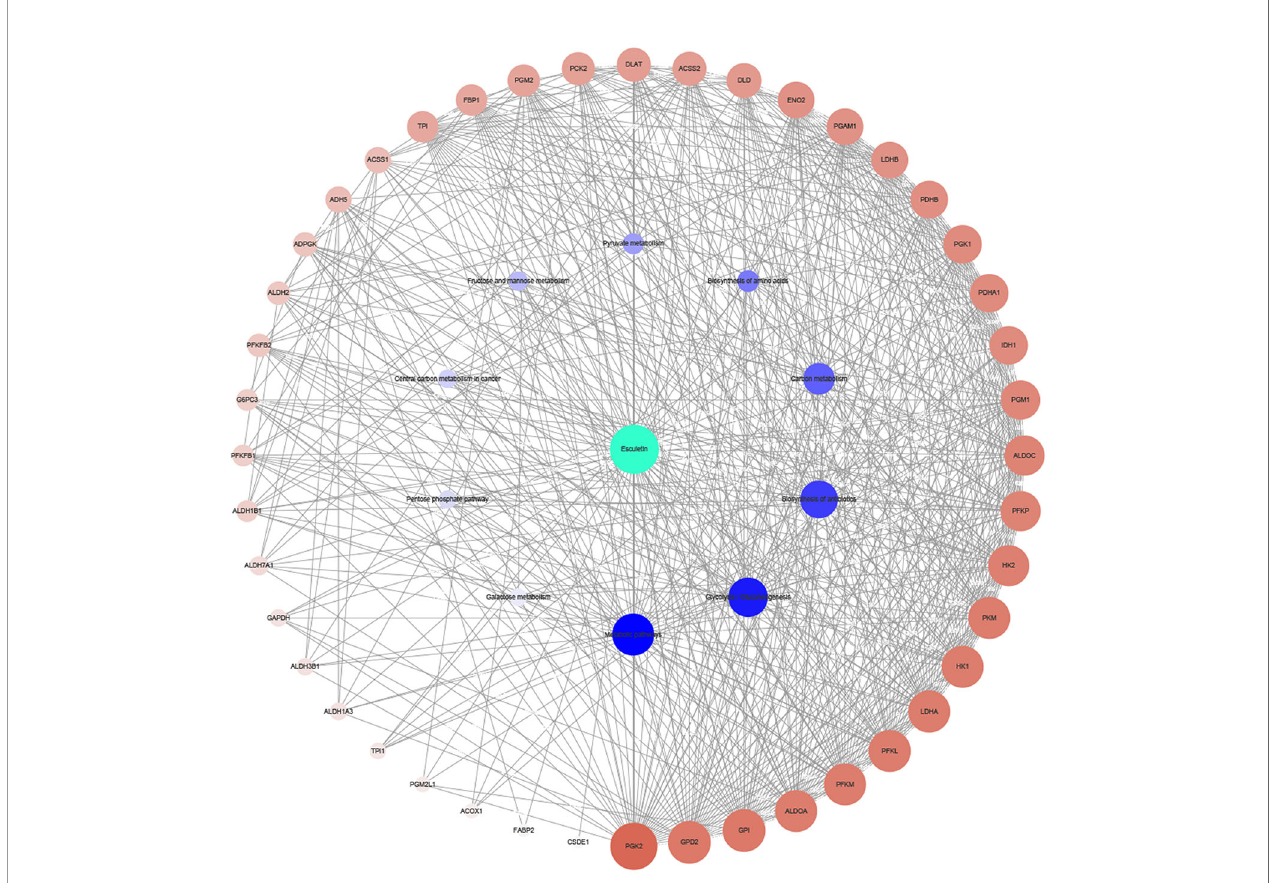
FIGURE 3 | Network diagram of active component (green)/target genes (brown)/enrichment pathways (blue) constructed by Cytoscape. The bigger and darker the dot, the more correlations it